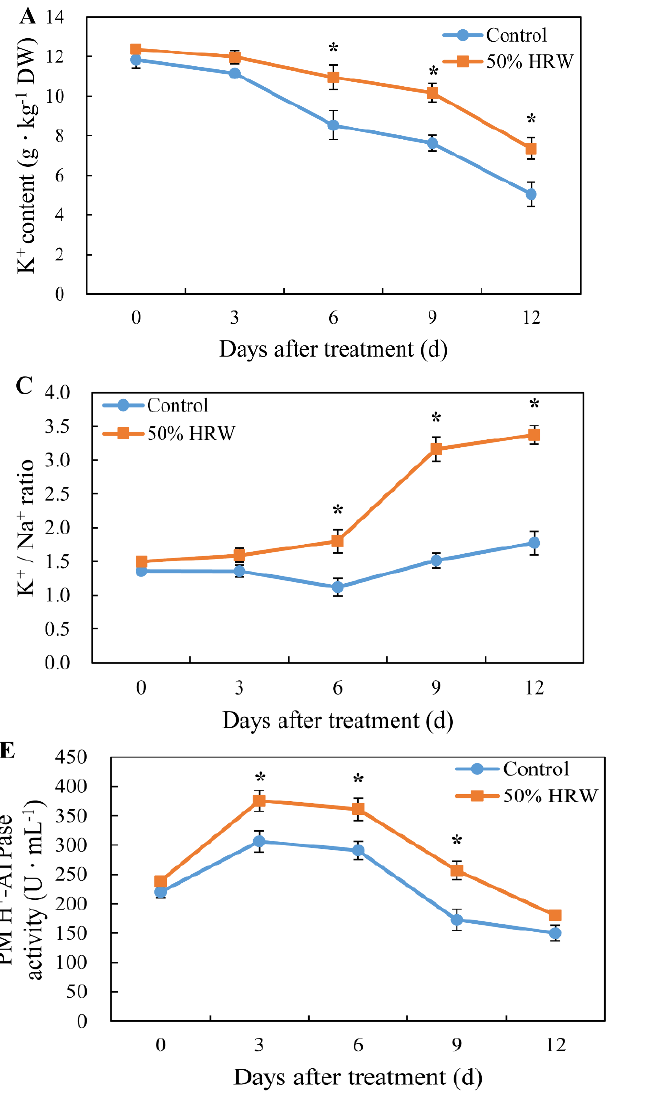
Figure 2. Changes in K + content ( A ); Na + content ( B ); K + /Na + ratio ( C ); Na + K + -ATPase activity ( D ) and PM H + -ATPase activity ( E ) of Lanzhou lily scales with or without 50% HRW treatment during storage at room temperature for 12 days. Values are the mean ± SE of three independent experiments. The asterisks denote t -test significance between the control and 50% HRW treatment on the same day: * p < 0.05. HRW: hydrogen-rich water.